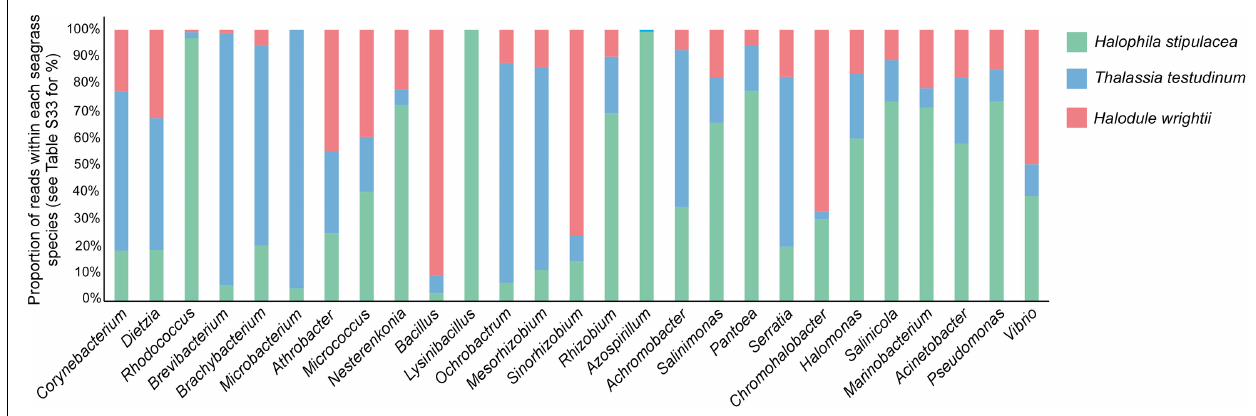
FIGURE 8 | Relative abundance of potentially halophilic/halotolerant bacteria (according to Etesami and Beattie, 2018) associated to each of the seagrass species sampled in all the locations and independently of the tissue. Proportions were calculated, for each species, by dividing the number of reads of each halotolerant bacteria by the total number of reads in that species. Due to the low value and high discrepancy among proportions for each halotolerant genus, a regular bar chart would not allow the visualization of all the bars for all the genera; therefore, we used a 100% stacked column chart. The graph is displaying the relative composition of halophilic/halotolerant bacteria (according to Etesami and Beattie, 2018), which represents less than 2% of the overall associated bacterial community. Real proportions are presented in Supplementary Table 28 .